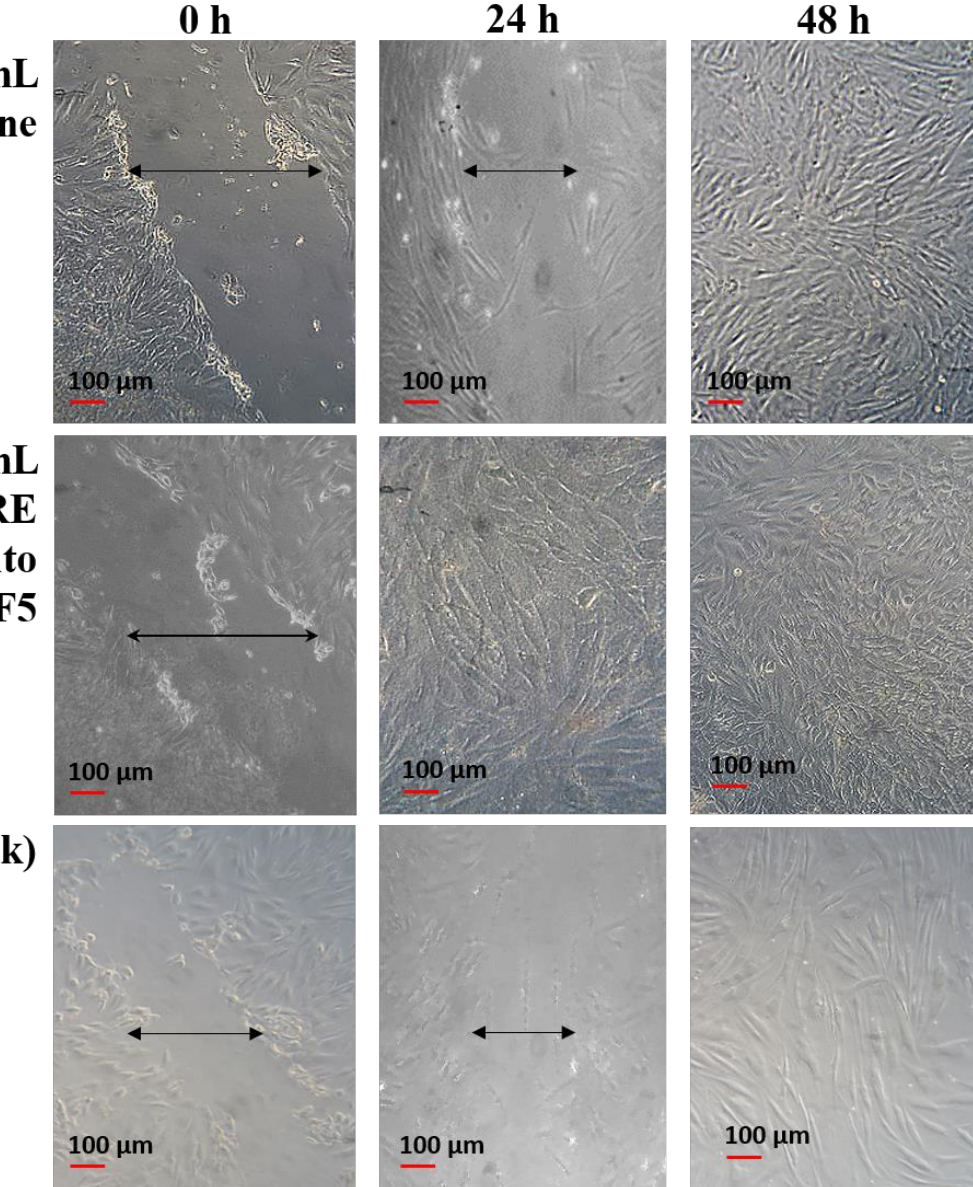
Figure 6. Cell migration for HLRE and thermoresponsive gel (F5) containing HLRE.